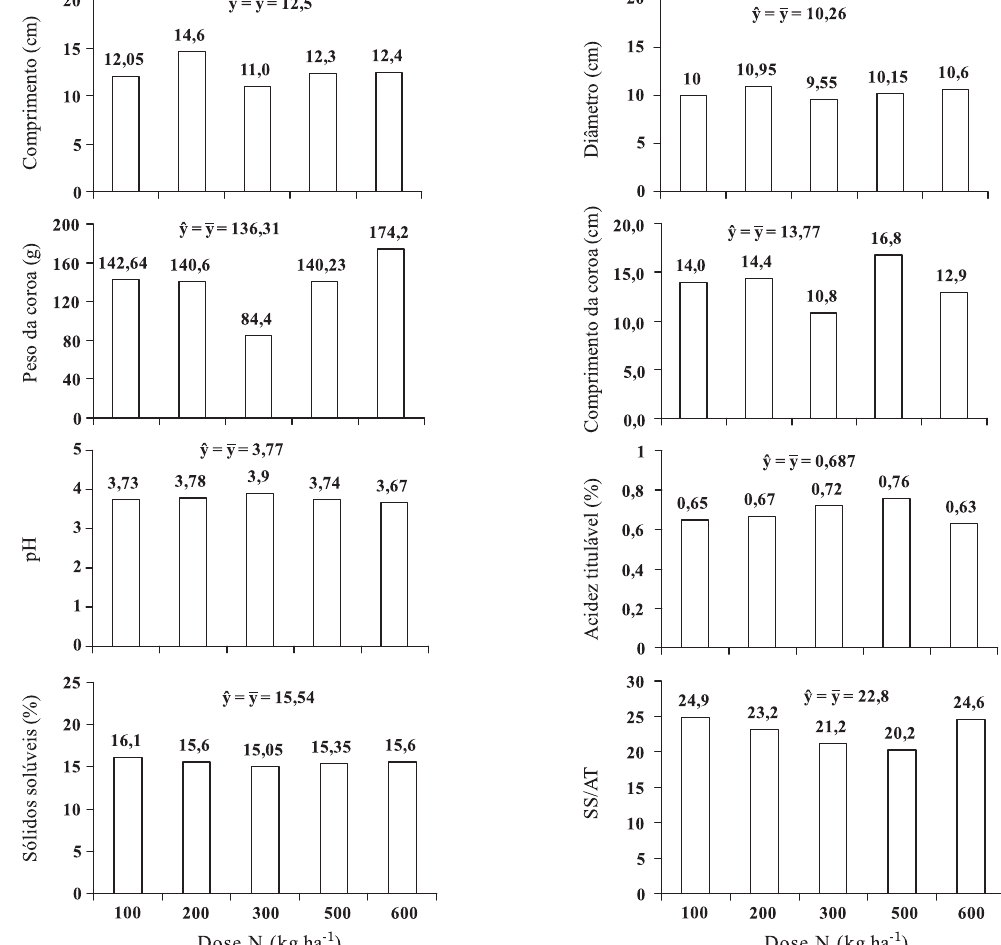
Figura 4. atributos físicos (comprimento e diâmetro de infrutescências; peso e comprimento de coroa) e químicos (pH, acidez titulável, sólidos solúveis e relação ss/at) de abacaxizeiros ‘Vitória’, em função das doses de